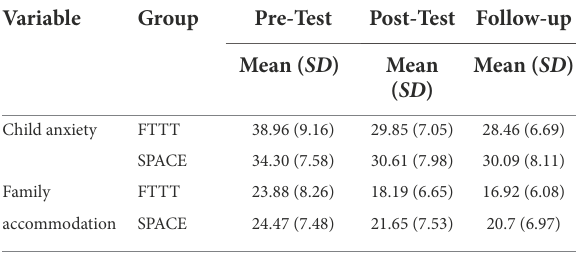
TABLE 3 Content of the SPACE program sessions.